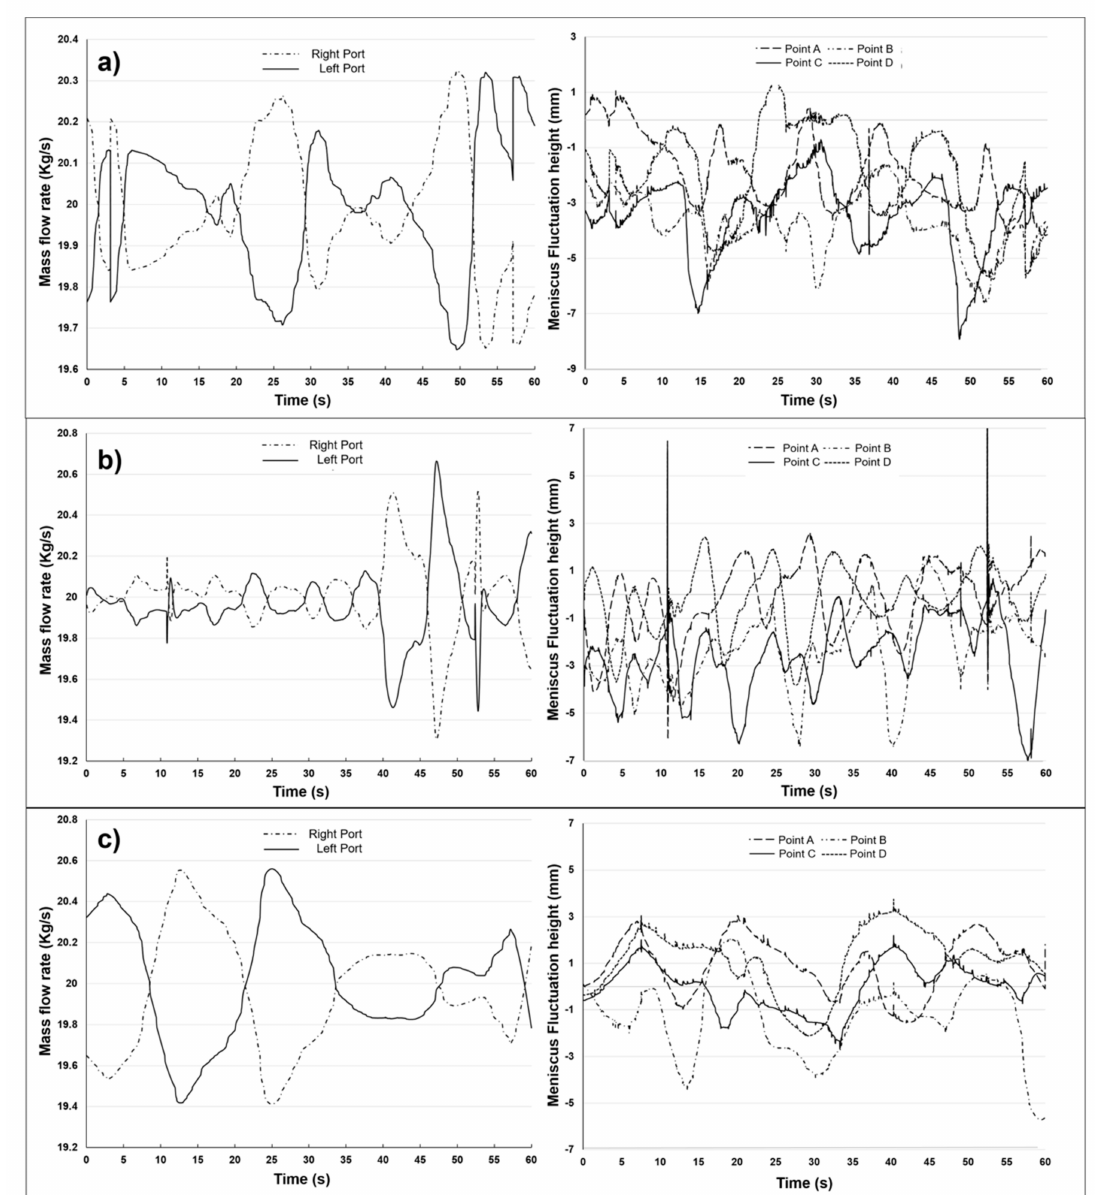
Figure 12. Mass flow rate in the SEN ports and meniscus fluctuation height during 60 seconds at unsteady-state conditions, V-EMBr, ( a ) 0.3, ( b ) 0.4 and ( c ) 0.5